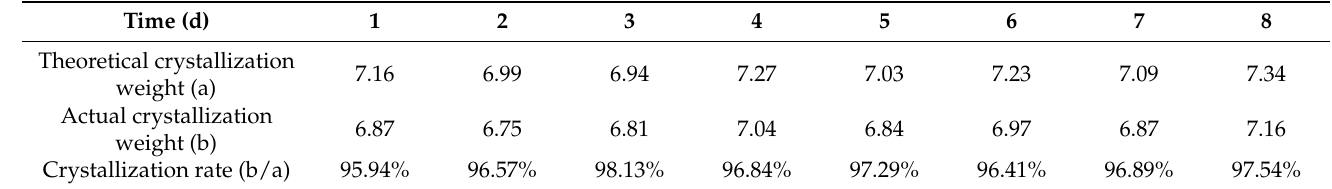
Figure 8. Concentrated water crystal after salt drying. Table 4. Crystal precipitation effect.